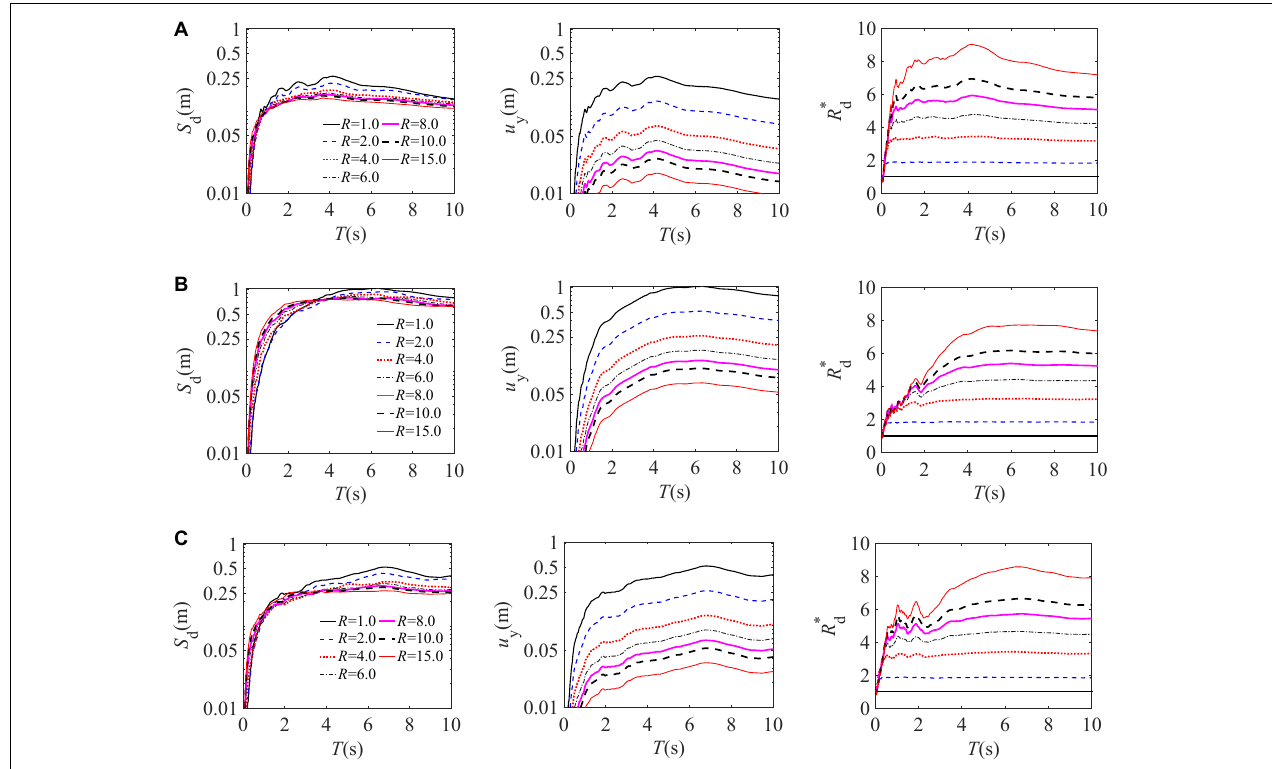
FIGURE 4 | Mean inelastic displacement spectra, yield displacement spectra and force-reduction factor spectra for the (A) 40 FF components; (B) 20 FD-NF components; (C) 20 PD-NF